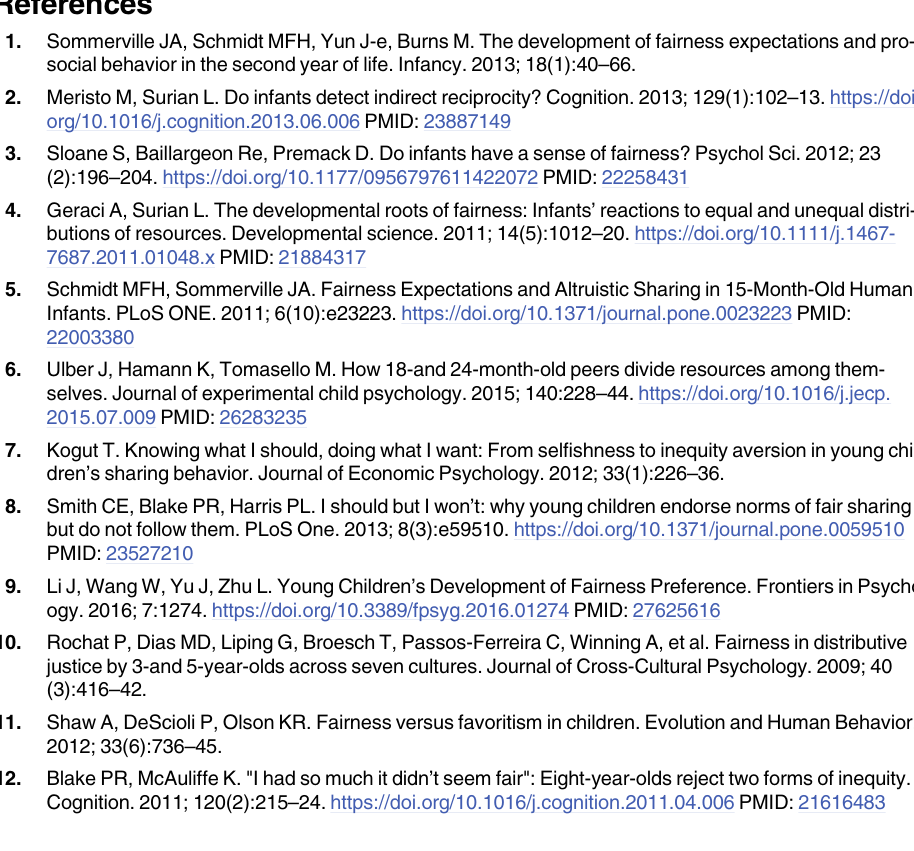
S1 Table. Raw data for main analysis including children’s choices in the two tasks.